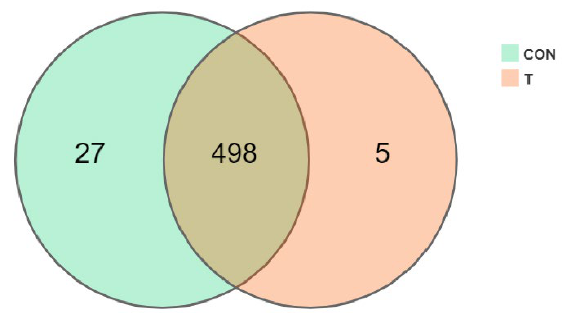
Figure 5. Influence of ALE on OTU.